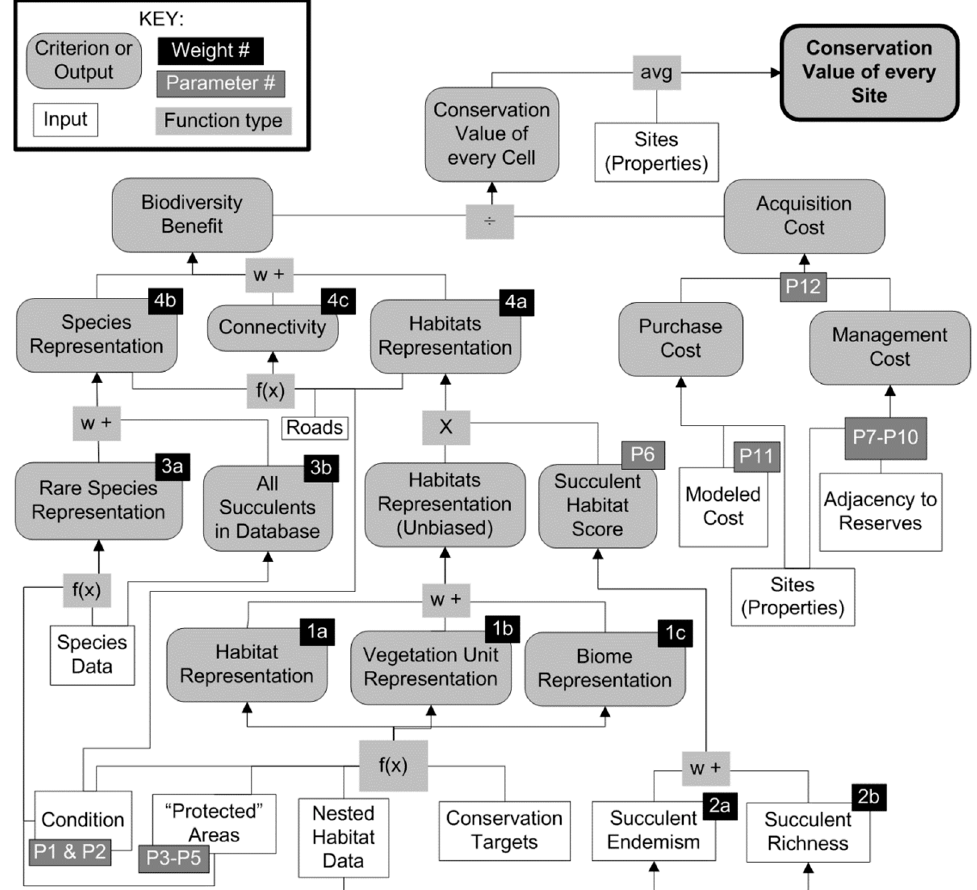
Figure 2. Diagram of the multi-criteria model within the spatial decision support system. All the criteria can be useful outputs communicated via individual maps and tables. The weight and parameter identification numbers cross reference with Table 1. Function abbreviations: f(x) = complex function; w + = weighted sum; avg = average among cells per site; X = multiplication; ÷ = division.